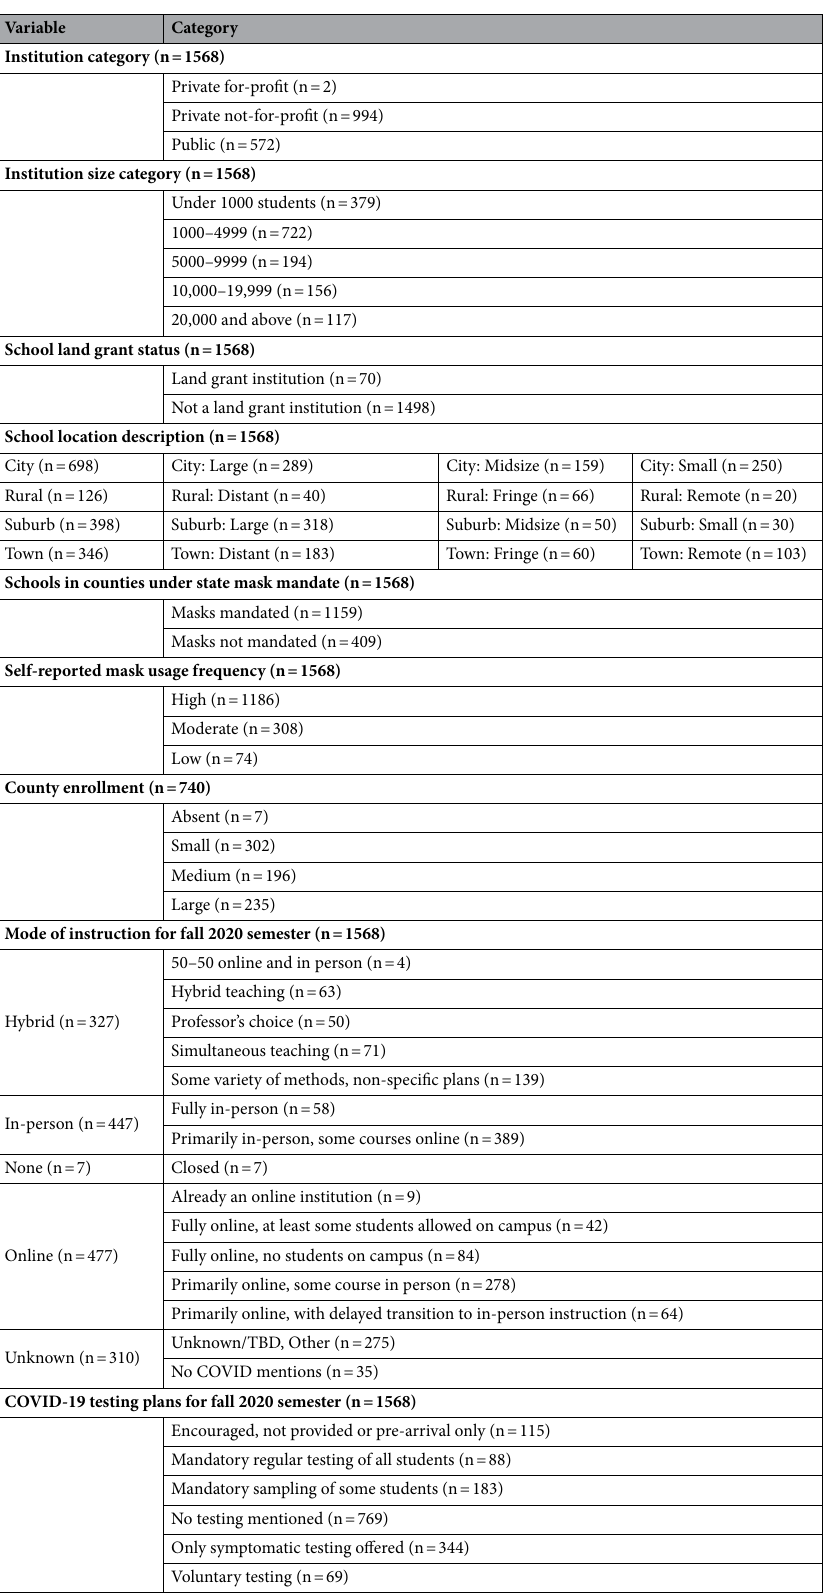
Table 3. Covariates included in (Aim 2) analysis of campus COVID-19 mitigation strategies for Fall 2020 semester (September 1st-December 31st) amongst college/university sub-sample (n =